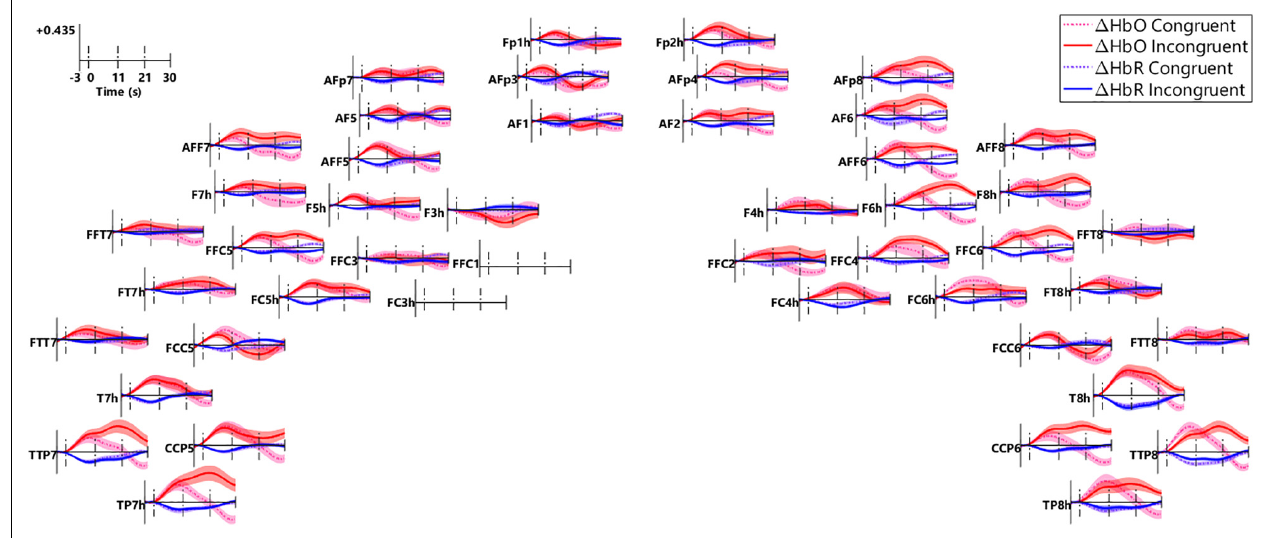
FIGURE 8 | Block-averaged fNIRS responses in all the channels. The small panel plots responses in individual channels ( n = 46), the locations of which correspond to those in Figure 2B . Block-averaged (cid:49) HbO (red) and (cid:49) HbR (blue) responses in the congruent (dash lines) and incongruent conditions (solid lines) were plotted. Responses were examined in three periods, i.e., the pre-incongruence period (0–11 s, first two vertical dash lines), the intra-incongruence period (11–21 s, the second and third dash lines), and the post-incongruence period (21–30 s, after the third vertical dash line).